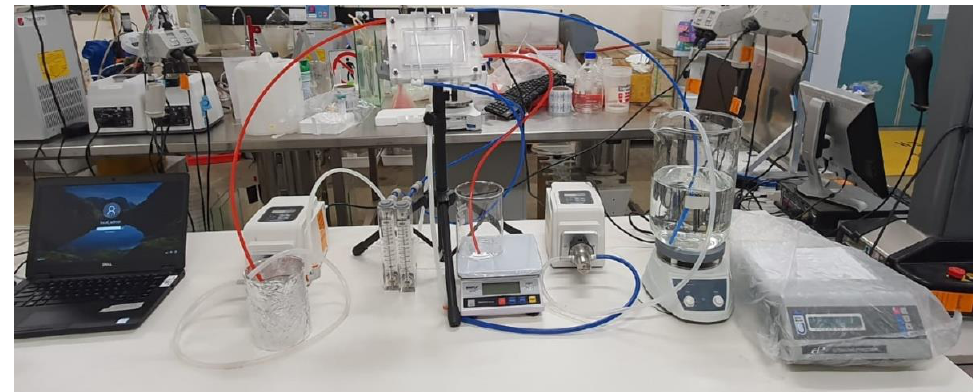
Figure A1. Schematic diagram of the AGMD setup. Pore Size Analysis